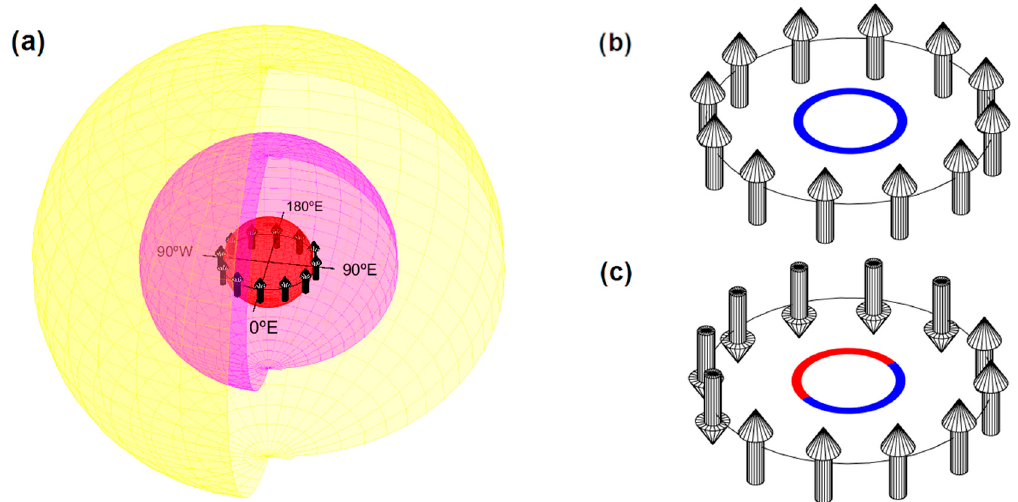
Figure 1. Schematic representation of the 360-dipole ring model (360-DRM). ( a ) Distribution of the dipoles (white) close to the ICB (red). The CMB (magenta) and the Earth’s surface (yellow) are also shown. ( b , c ) Equivalence between the polarities of the dipoles with blue/red circumferences, which will be used in the following figures.